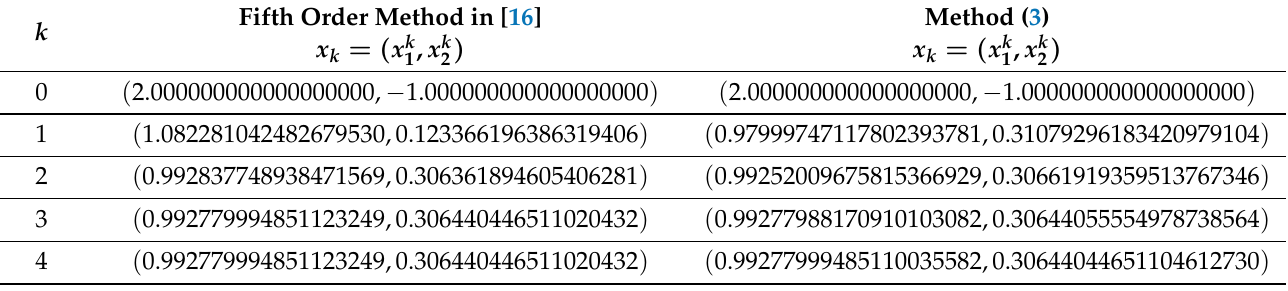
Table 1. Method (3).